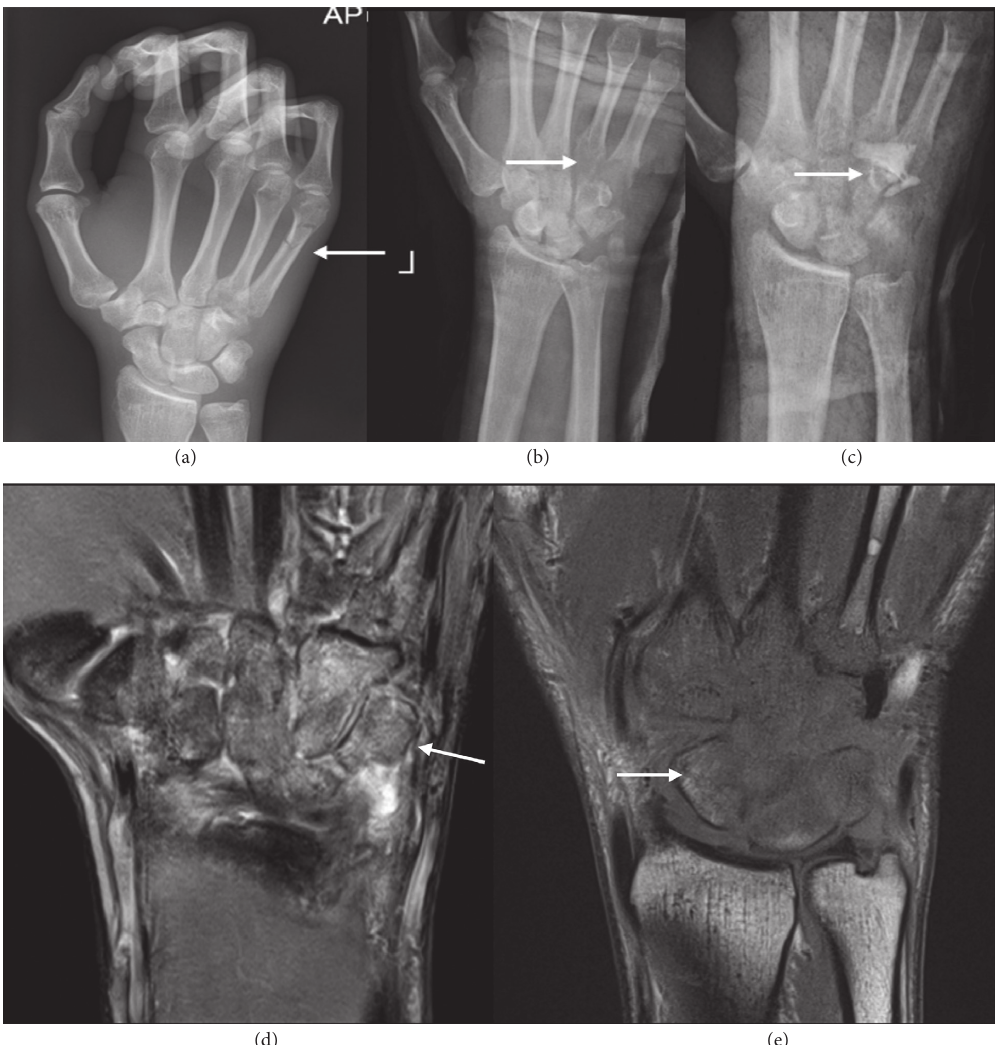
Figure 3: A 45-year-old man involved in a motor vehicle accident sustained an undisplaced 5 th metacarpal shaft fracture ((a), arrow). Repeating X-ray 16 days later (b), given the persistent pain, revealed rarefaction of 4 th and 5 th carpometacarpal (CMC) joints consistent with osteomyelitis and septic arthritis (arrow). X-ray-following washout and introduction of antibiotic-impregnated cement spacer (arrow). Coronal STIR (d) and T1 (e) sequences of the wrist show the extent of the infection involving all carpal bones and base of the 2 nd to 5 th metacarpals.